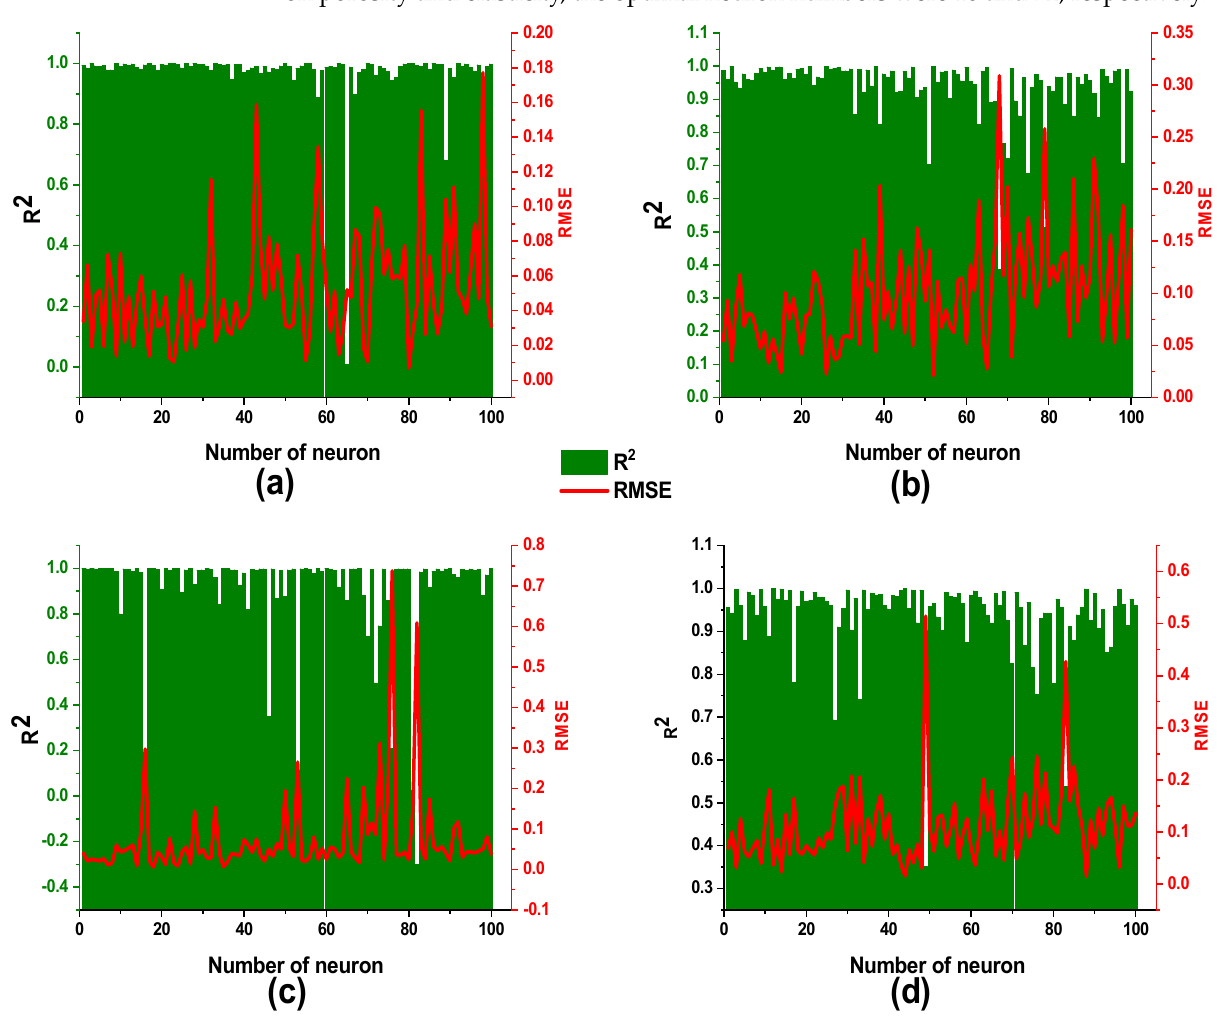
Figure 7. LM optimum number of neurons for ( a ) porosity-based D T under slow cooling, ( b ) elasticity-based D T under slow cooling, ( c ) porosity-based D T under rapid cooling, and ( d ) elasticity-based D T under rapid cooling.